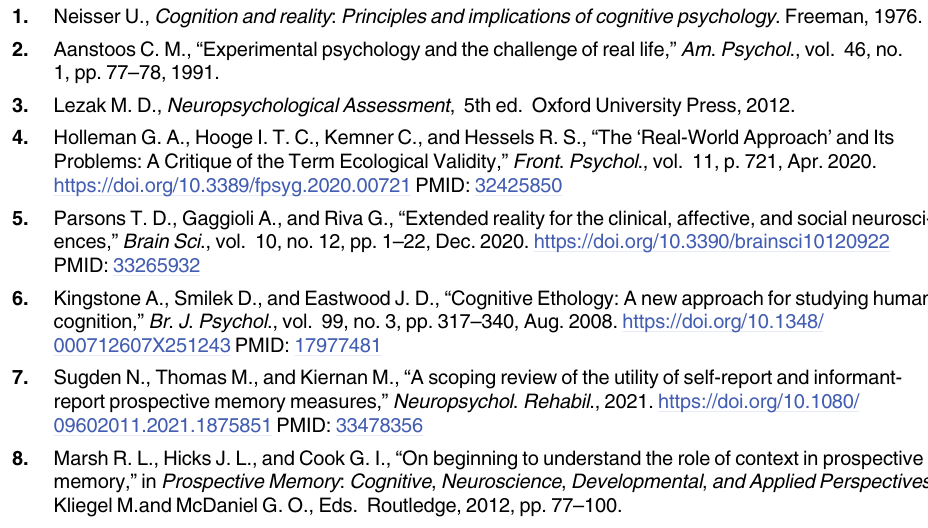
S1 Table. Reliability in EPELI as a function of number of scenarios from the beginning of the task. S2 Table. Correlations between all the self-report